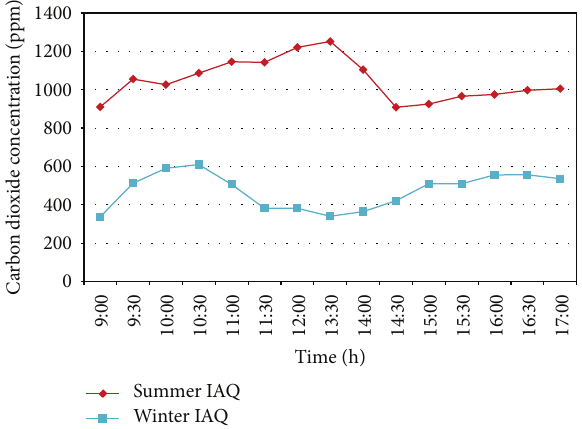
Figure 3: The distribution of measured indoor carbon dioxide concentrations in summer and winter, respectively.